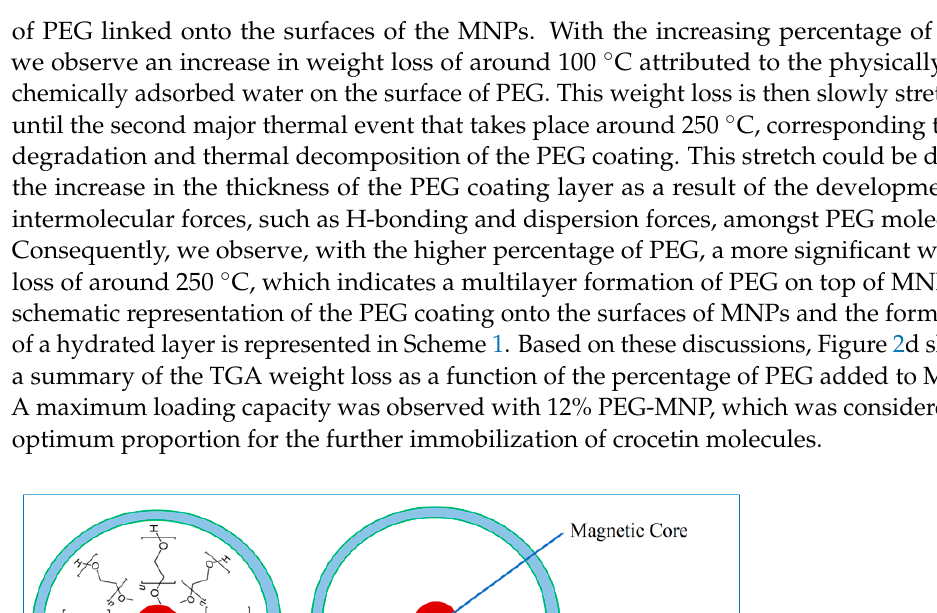
Scheme 1. Mechanism of the formation of PEG and hydrated layers onto MNPs surfaces .